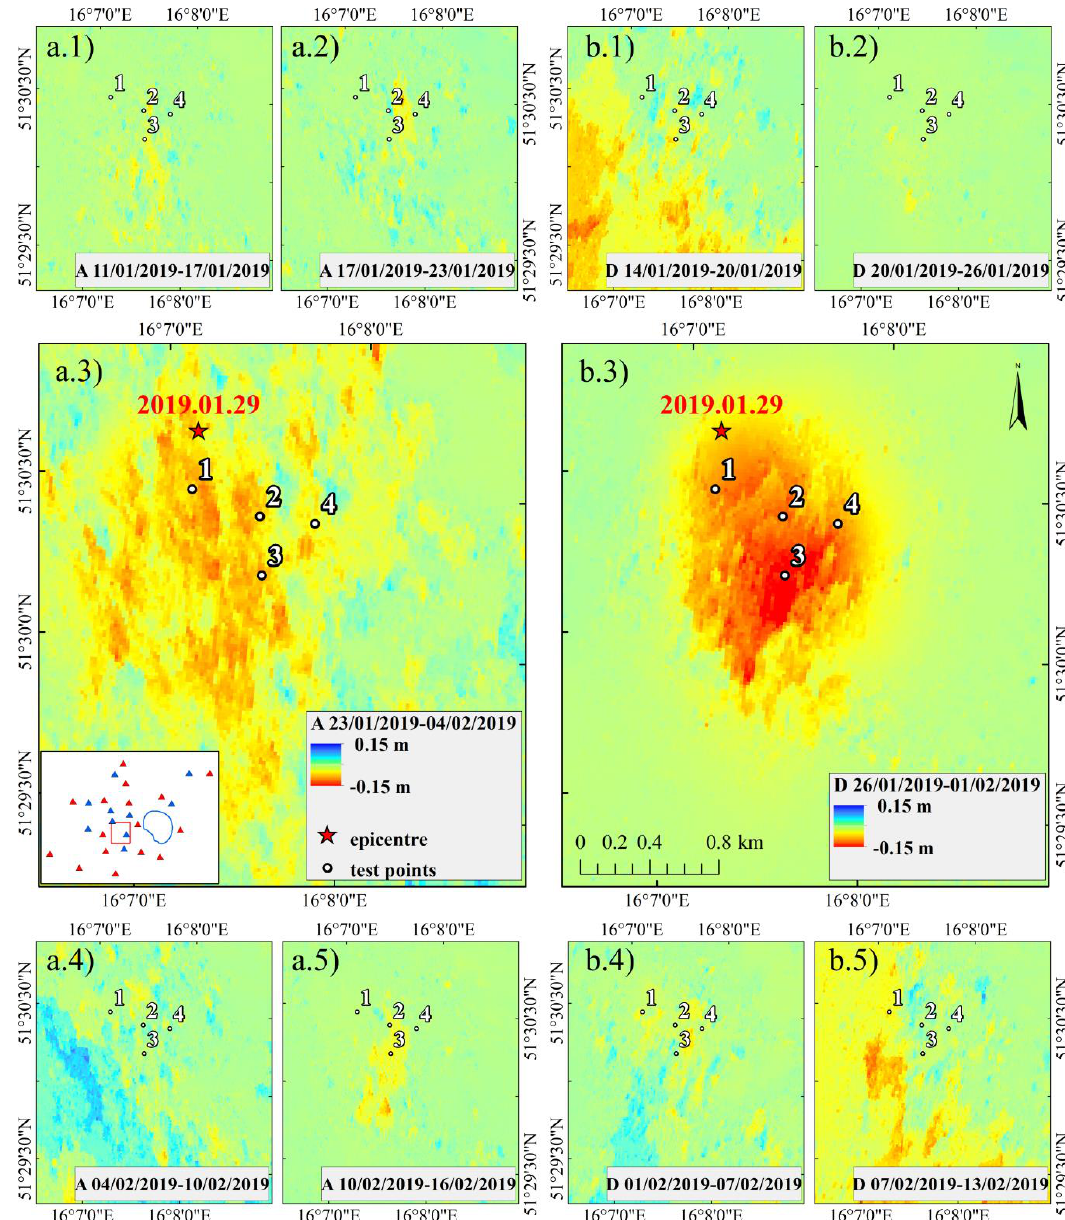
Figure 5. Vertical deformation patterns derived from the ascending ( a ) and descending ( b ) DInSAR interferograms: ( 1 ) and ( 2 ) pre-seismic; ( 3 ) co-seismic—(a.3) 12-day and (b.3) six-day; and ( 4 ) and ( 5 ) post-seismic. The images used for each interferogram are shown in the format DD/MM/YYYY. The red star represents the epicentre. The numbered dots are the points chosen for time-series comparison (Figure 6). The inset in (a.3) shows the footprint (red rectangle) of the DInSAR results over the local LUMINEOS network. The blue polygon represents the Żelazny Most tailings pond.